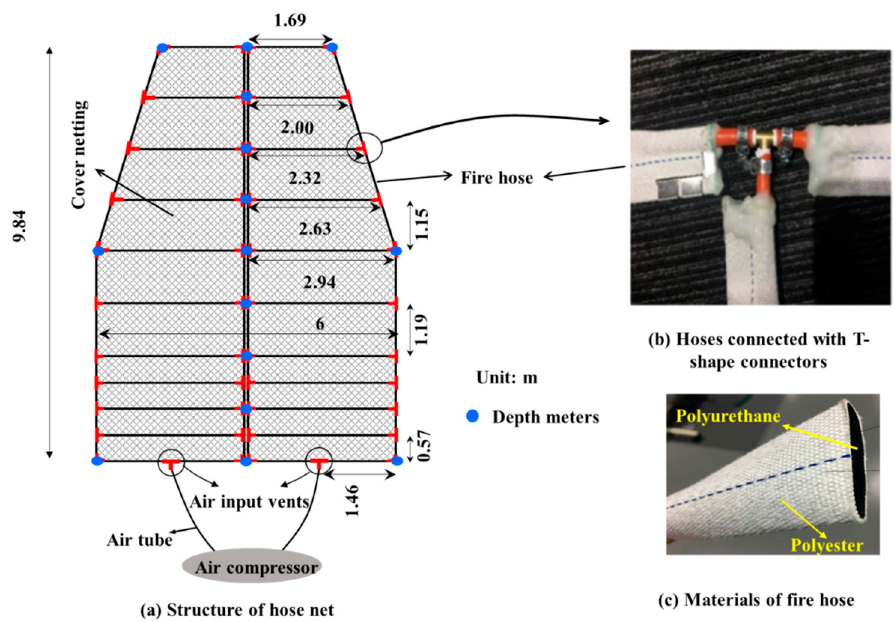
Figure 3. Structure of the newly developed hose net.